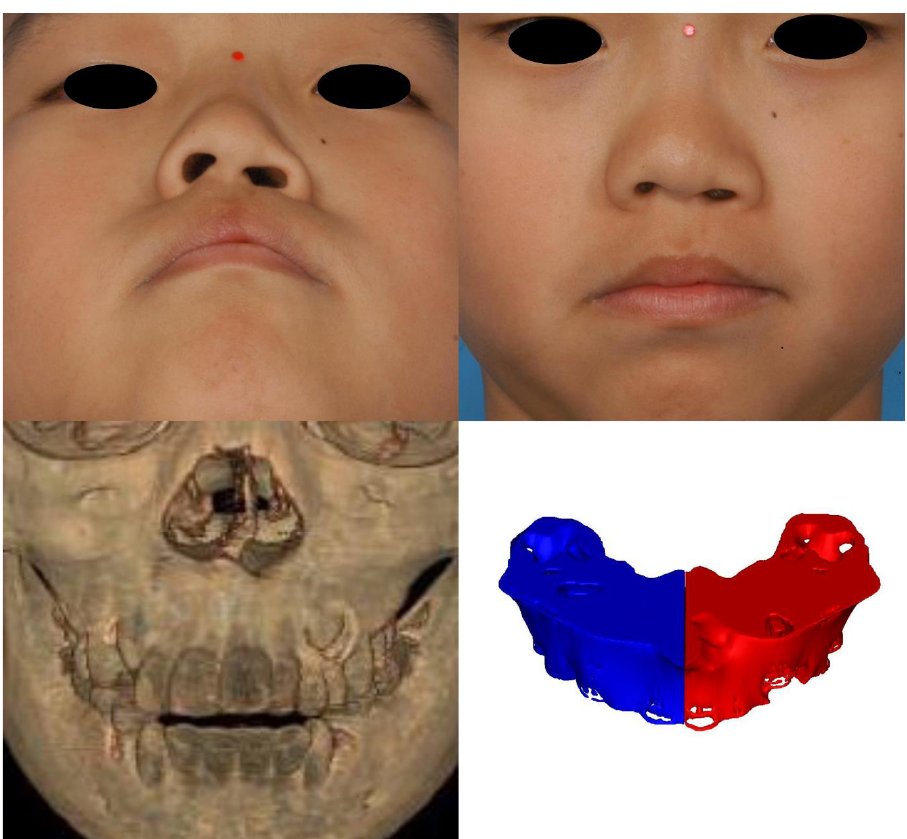
Figure 7. Case 2. A 9-year-old male patient. ( upper ) Worm’s-eye view and frontal view. A typical phenotype of microform cleft lip, an inferolaterally displaced nostril and a notch on the vermilion- cutaneous junction, is shown. ( lower, left ) Anterior view of the 3D-reconstructed computed tomog- raphy scan. The anterior nasal spine deviates to the nonaffected side, and the anterior nasal crest is depressed on the affected side. ( lower, right ) The alveolar volume was 6718.81 mm 3 on the cleft side and 6354.36 mm 3 on the other side. The volume was larger on the cleft side, with a difference of 364.45 mm 3 .